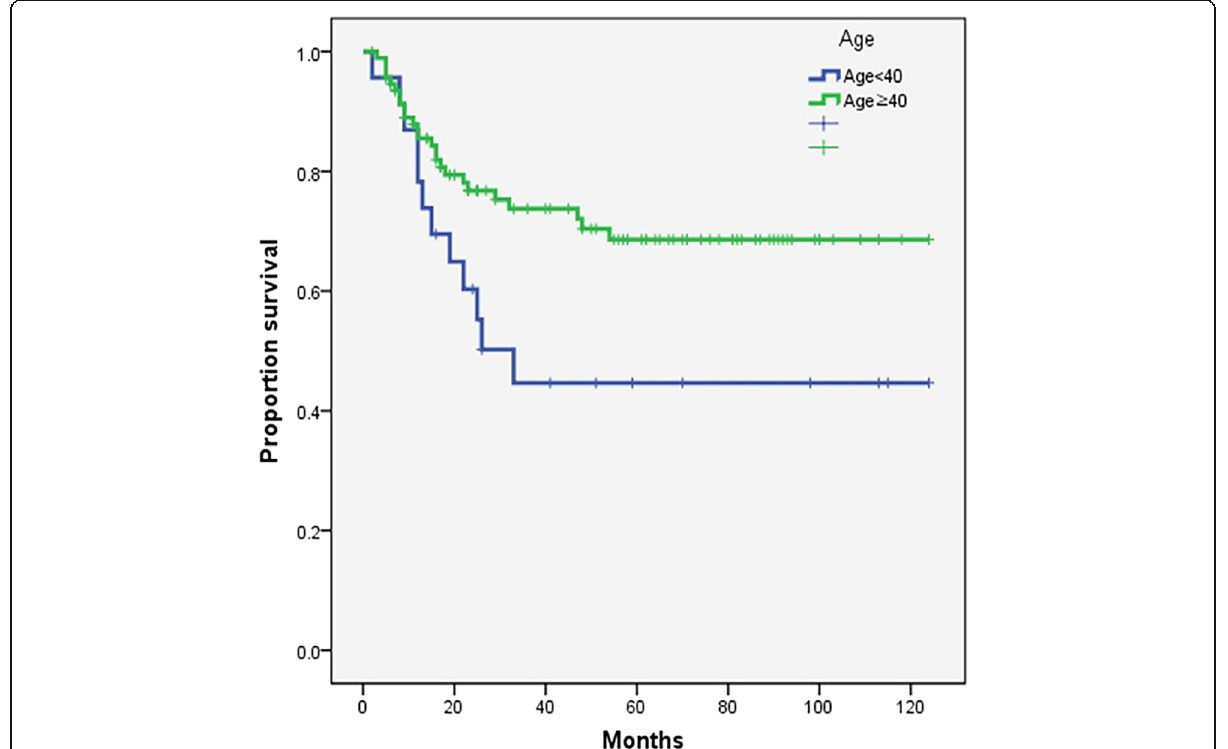
Fig. 3 Kaplan-Meier distant metastasis-free survival curve (log-rank p = 0.033)